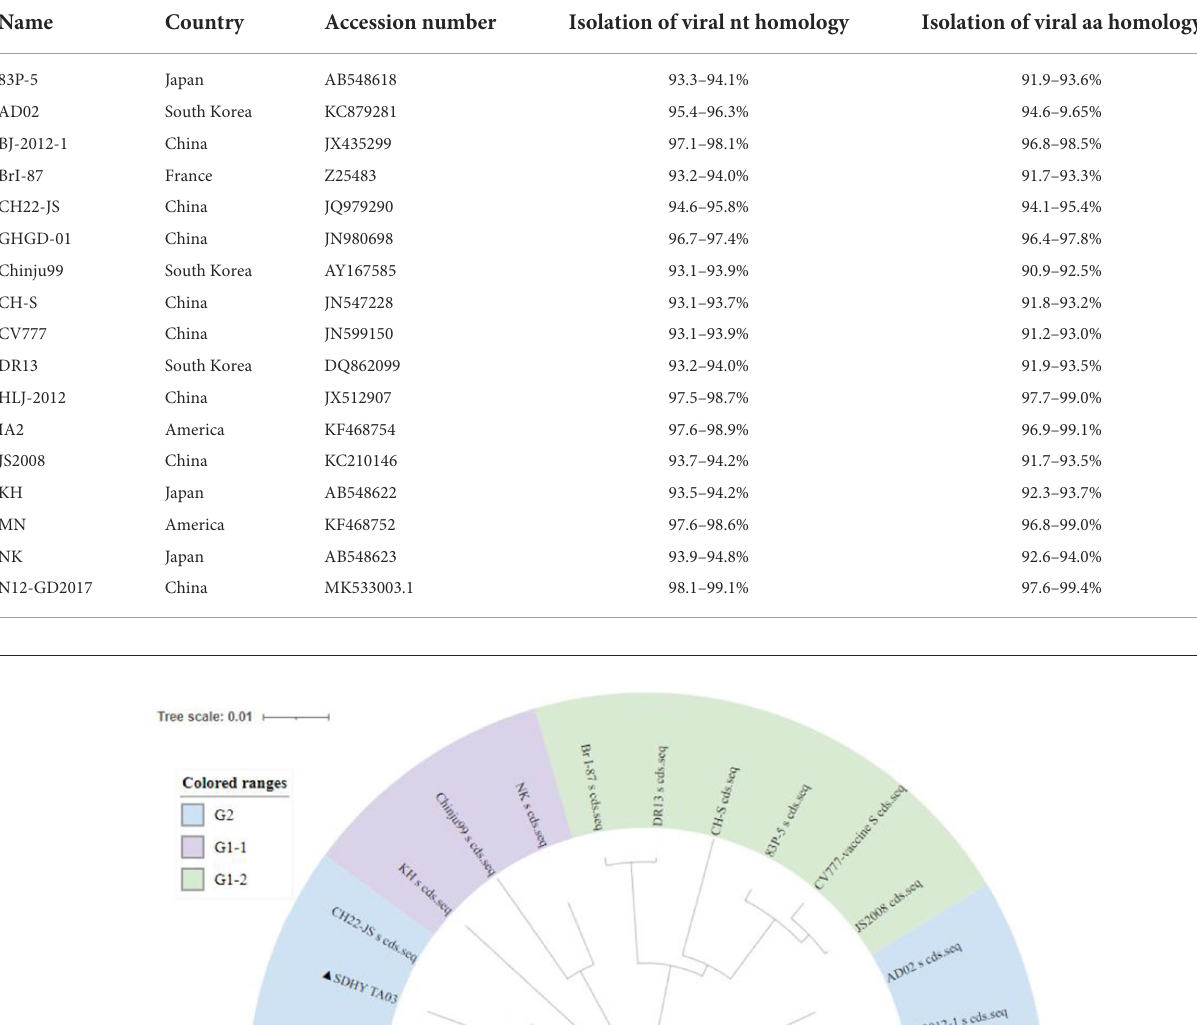
TABLE 4 Homology analysis of nucleotides and deduced amino acids.